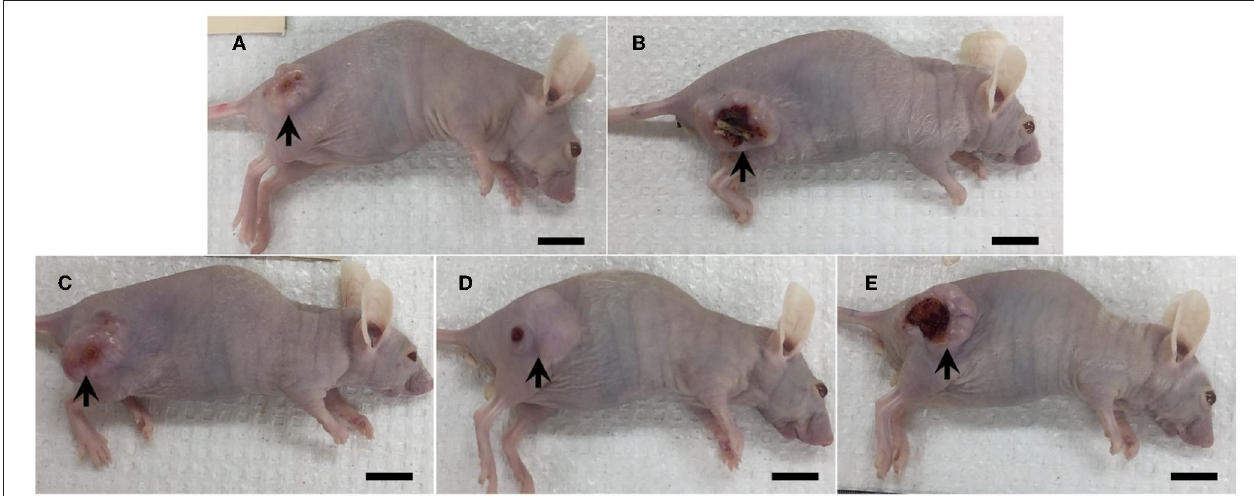
FIGURE 2 | Gross morphology of mice in the negative control group (A) , the positive control group (5-FU) (B) , and THC:CBD at the dose of 1 mg/kg BW (C) , 5 mg/kg BW (D) , and 10 mg/kg BW (E) , (scale bar = 1cm). Tumor mass was presented subcutaneously with ulcerated and necrosis in several mice (arrow).